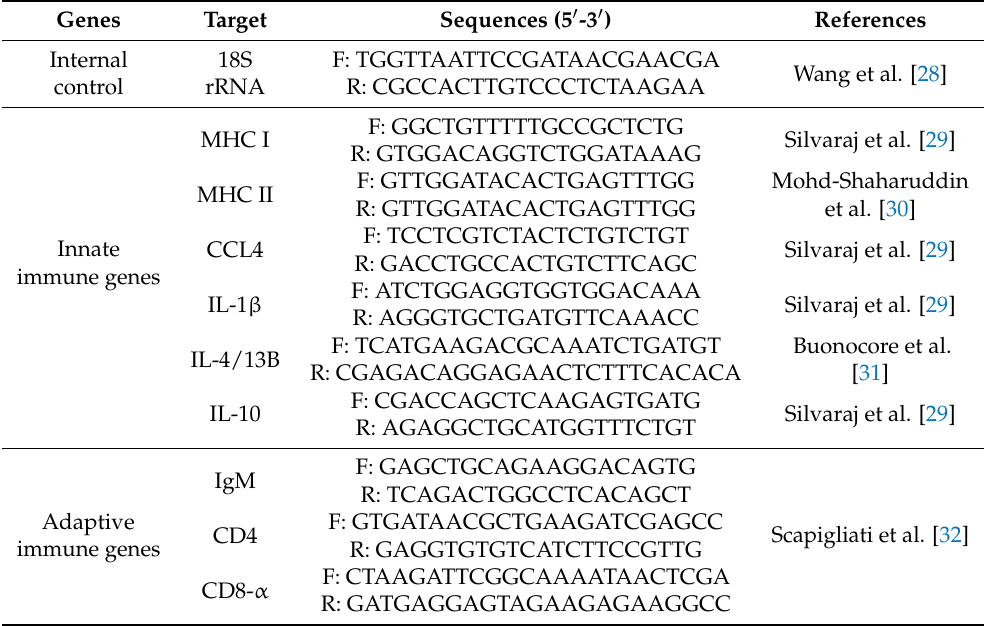
Table 1. Primer sequences used for